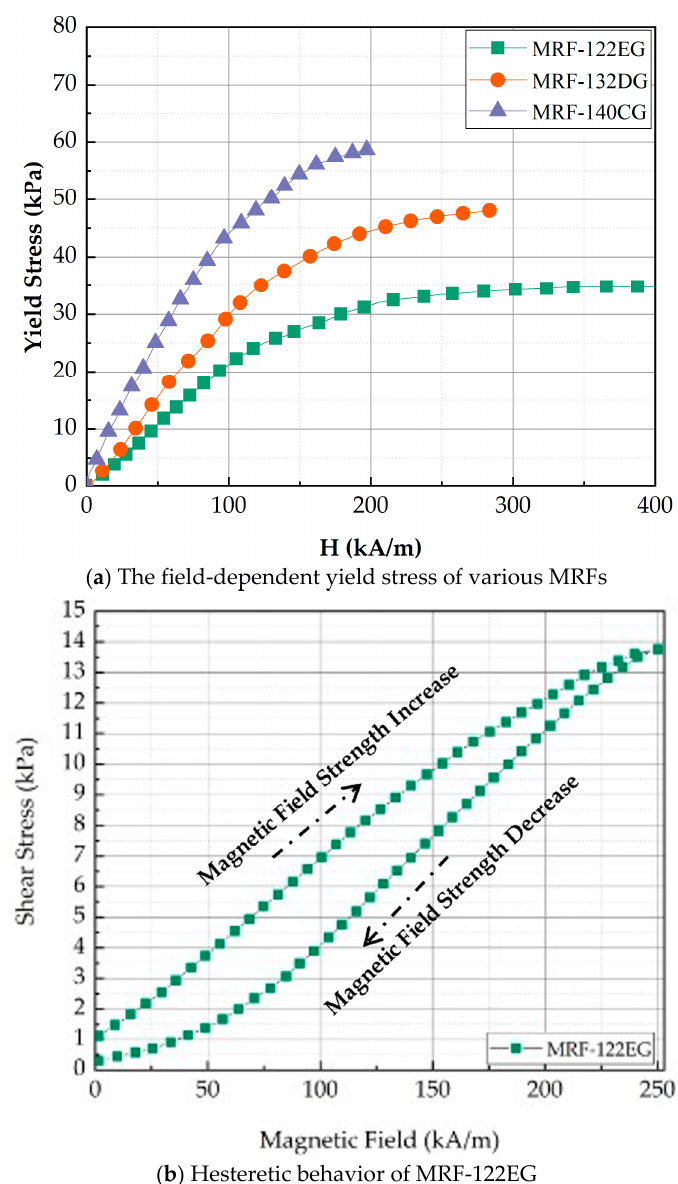
Figure 3. Properties of Magnetorheological Fluid.